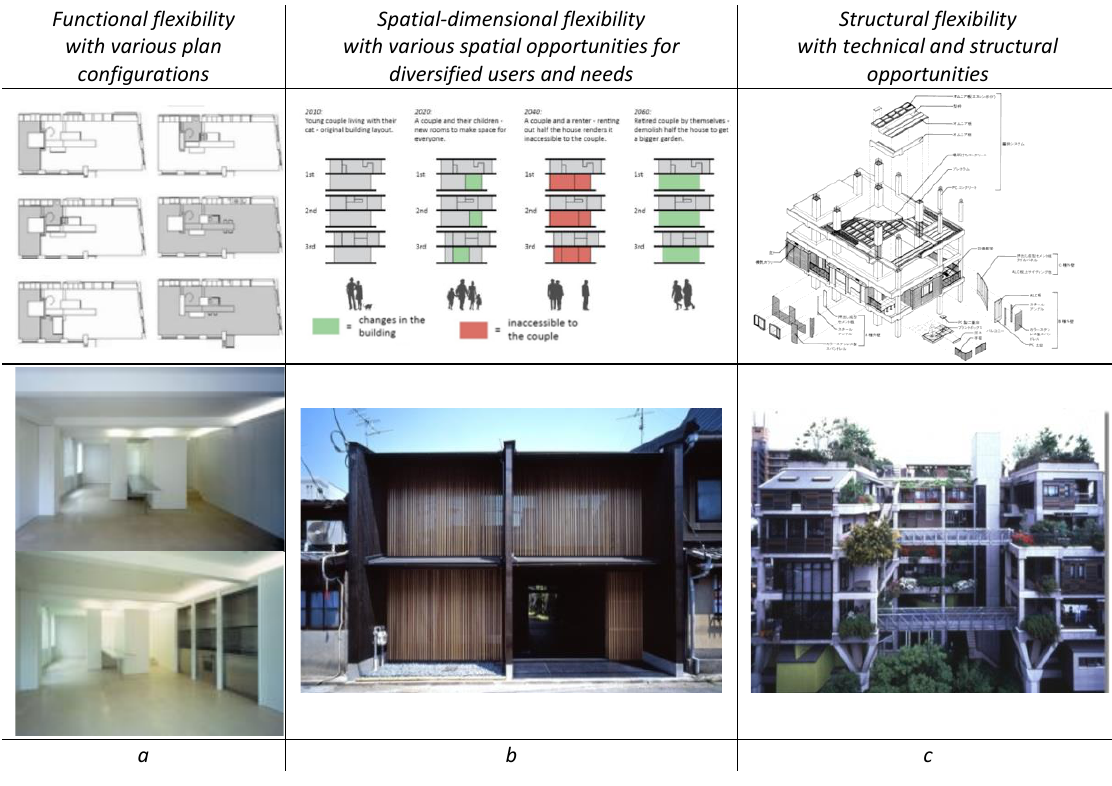
Figure 6 Flexibility types and methods, (a: URL-4, b: URL-5, c: